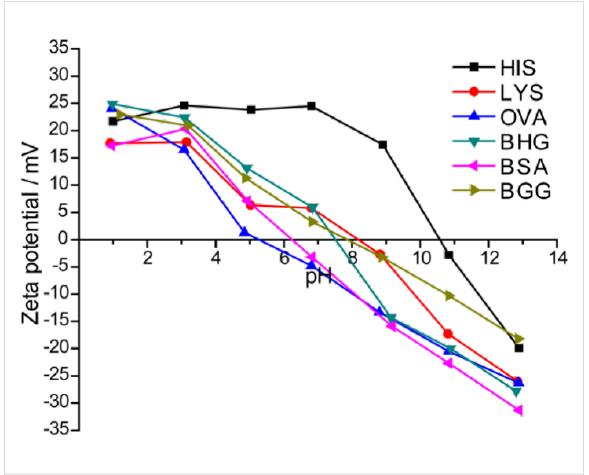
Figure 3: Variation in the zeta potential of AuNPs prepared by using different proteins as a function of the pH in aqueous medium.